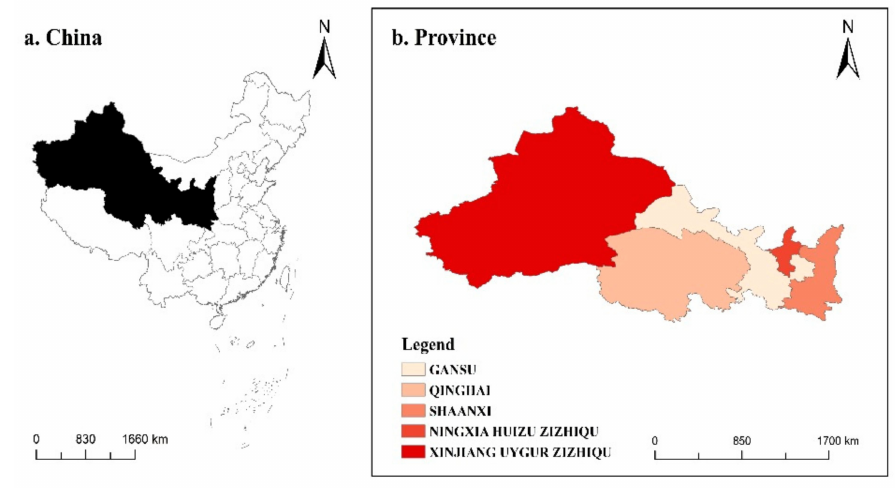
Figure 1. Map of five provinces in Northwest